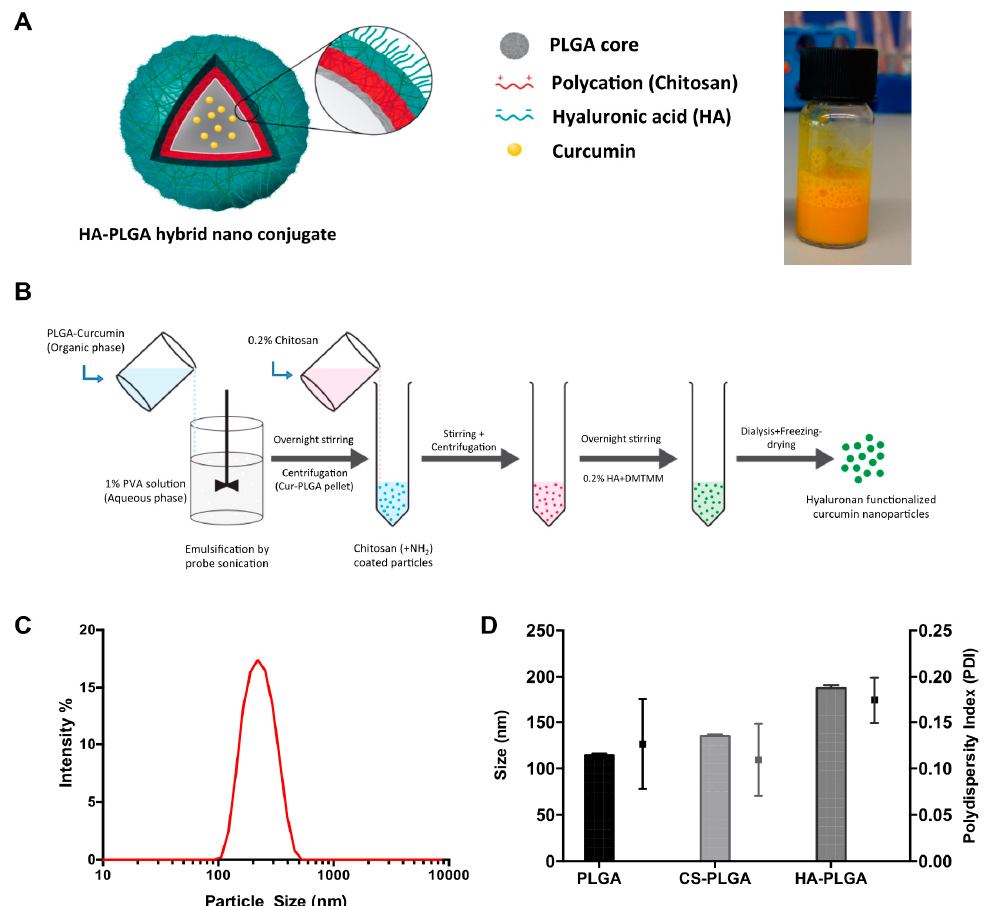
Figure 1. Concept figure of curcumin model drug loaded polymeric hybrid nanoparticles synthesis and